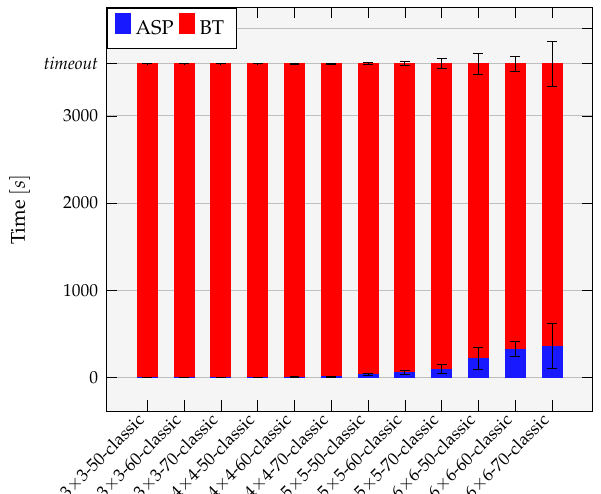
Figure 6. Average runtime distribution between answer set solver (blue) and background theory solver (red) for the timeout runs in the classical approach. More than 90% of the total synthesis time is spent on average within the background theory until the timeout. The vertical error bars show the standard